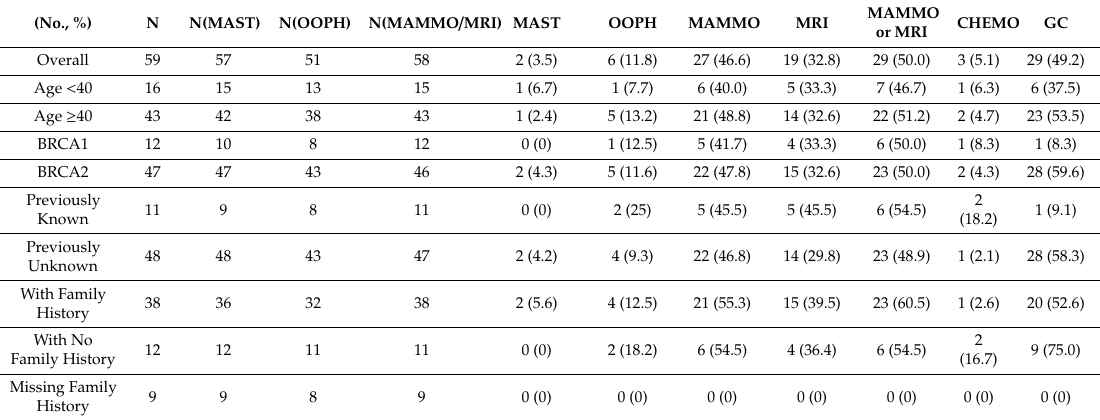
Table 4. Uptake of guidelines-recommended services within the first year post results